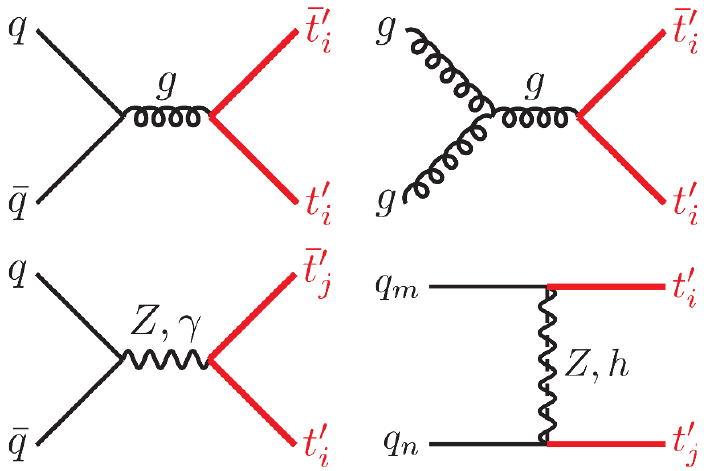
Figure 9 . Strong (top row) and weak (bottom row) tree level Feynman Diagrams for contributions to the pair production of Vector Like Top